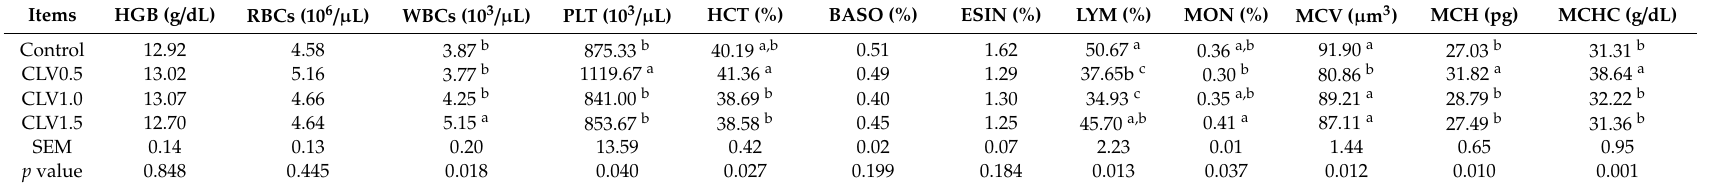
Table 5. Hematology of growing NZW rabbits as a ff ected by dietary treatments at 13 weeks of age.